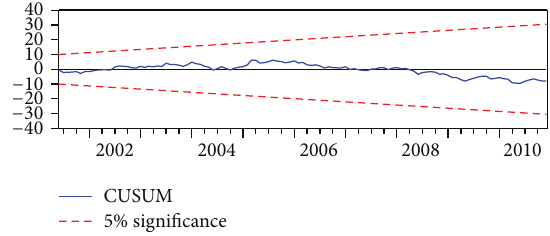
Figure 1: Plot of cumulative sum of recursive residuals. The straight lines represent critical bounds at 5% significance level.